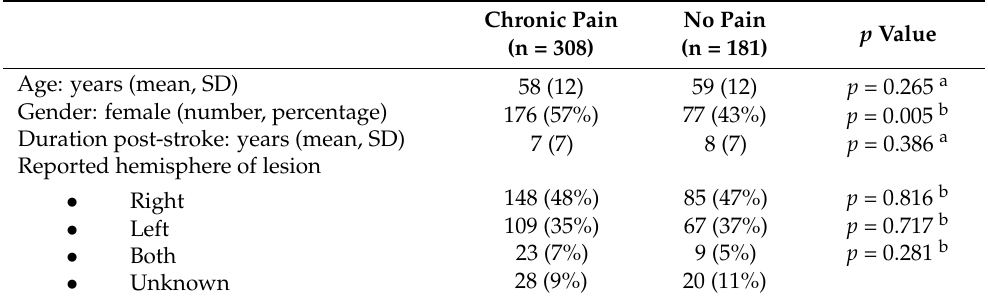
Table 1. Age, gender, stroke chronicity and reported hemisphere of lesion reported within samples with and without chronic pain.